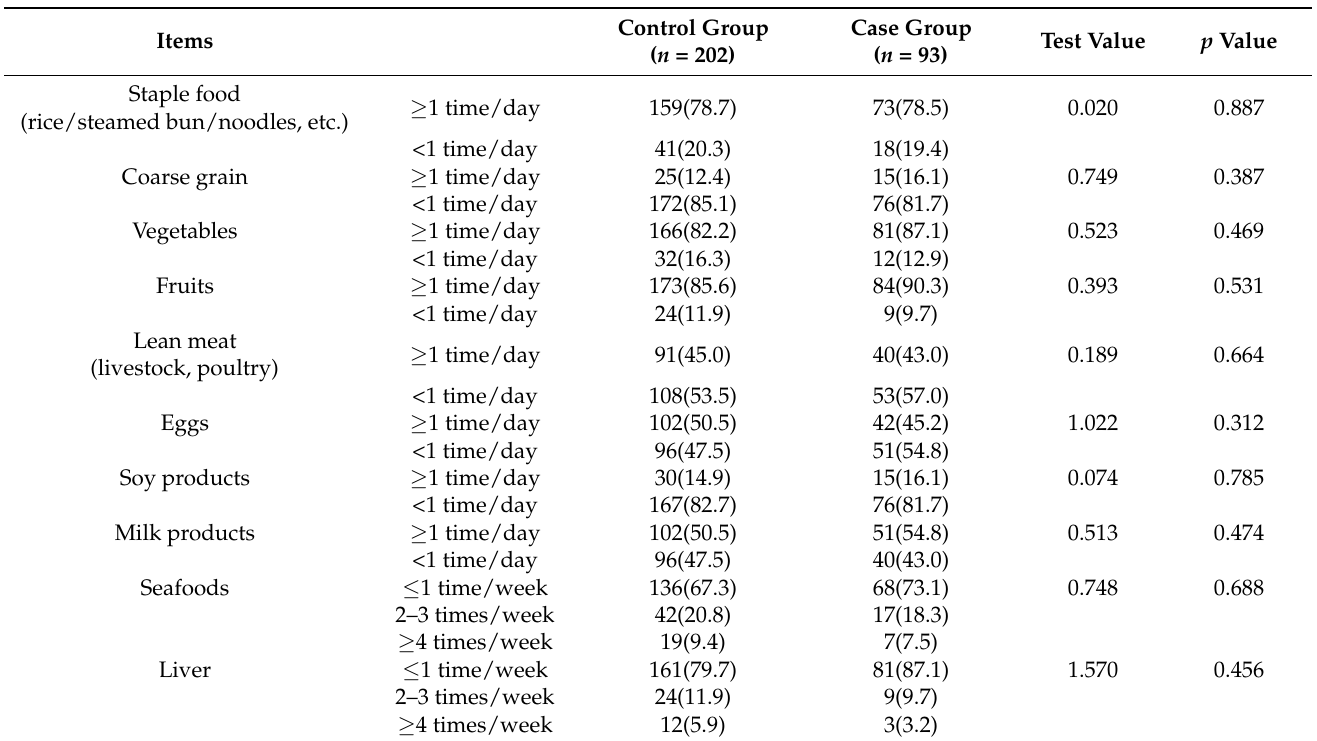
Table 6. Comparison of the common food intake frequencies of women during pregnancy between the control and case groups ( n ,